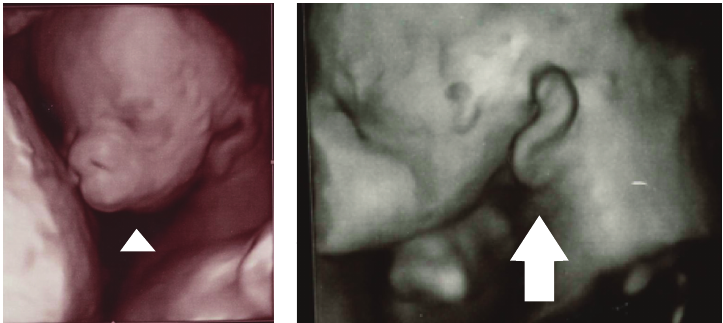
Figure 1: Three-dimensional ultrasonography demonstrated ventromedial displacement of the ear (arrow), small opening of the mouth, and mandibular agenesis (arrowhead).